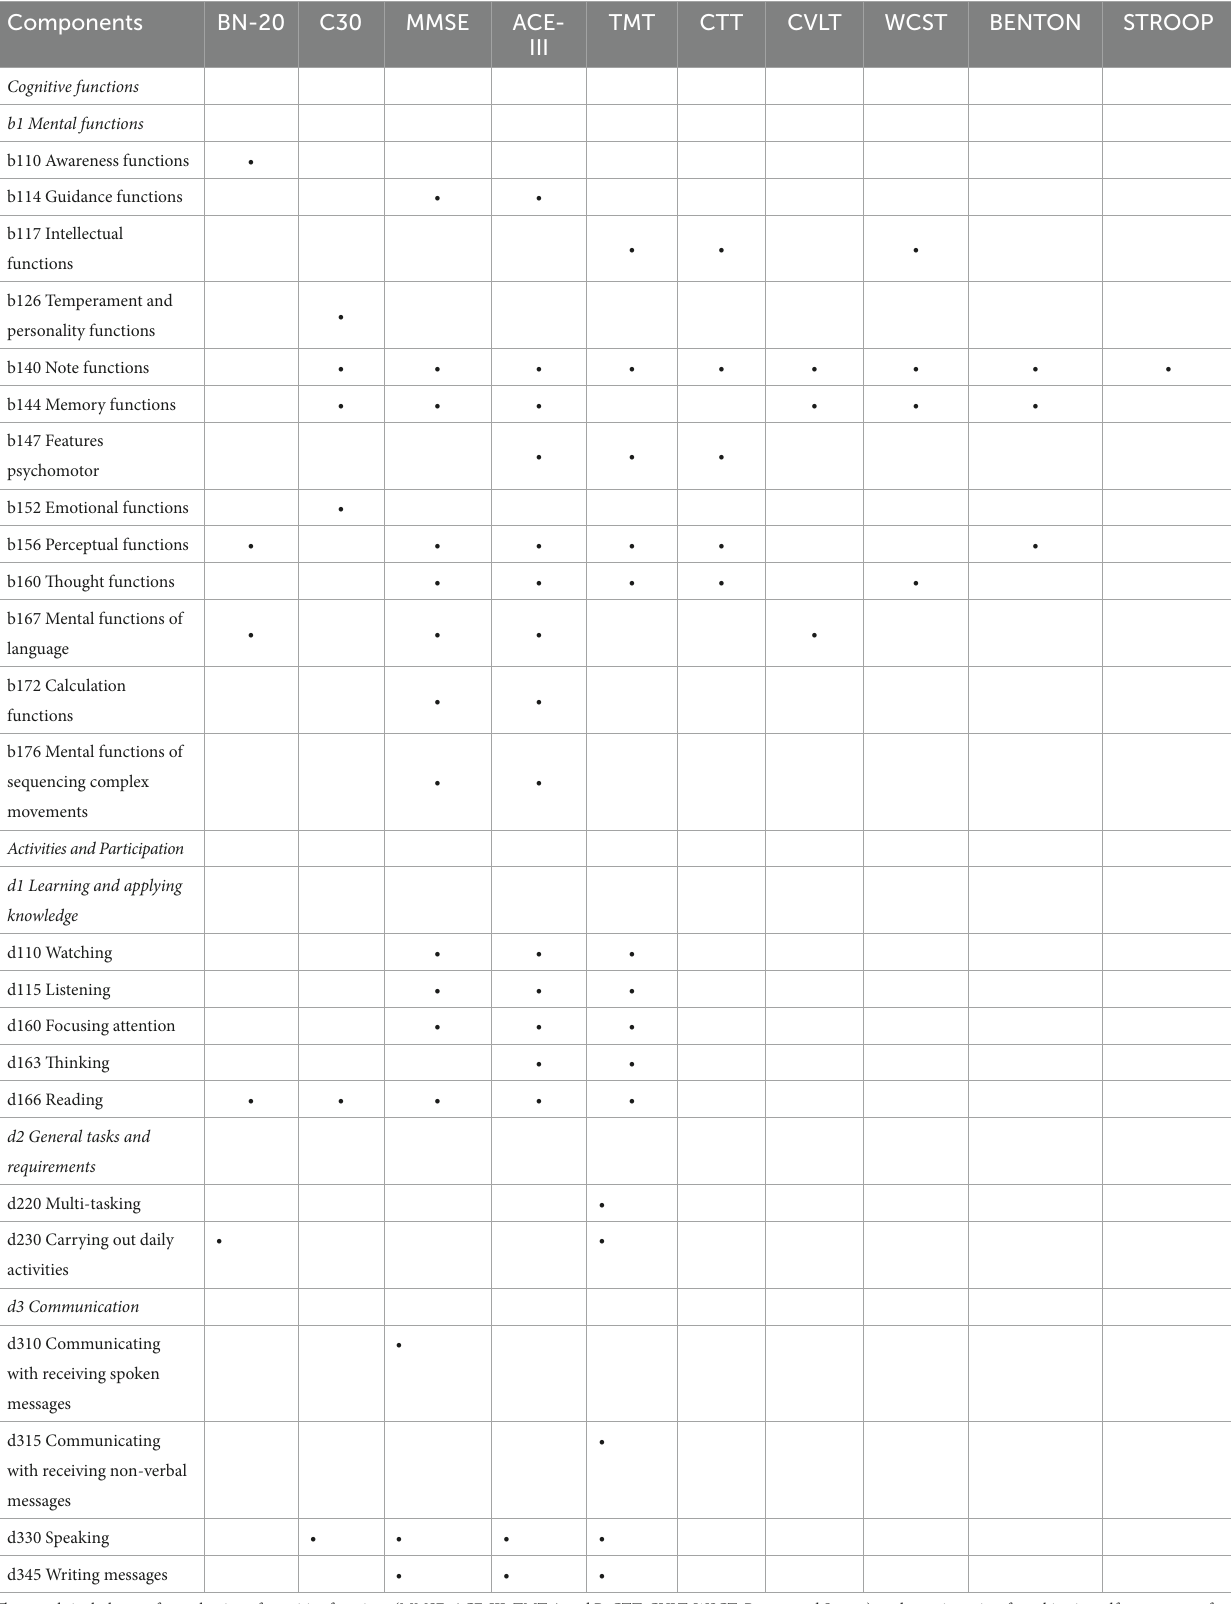
TABLE 1 The comparison of selected tools for cognitive diagnosis of patients with brain tumours with ICF components.